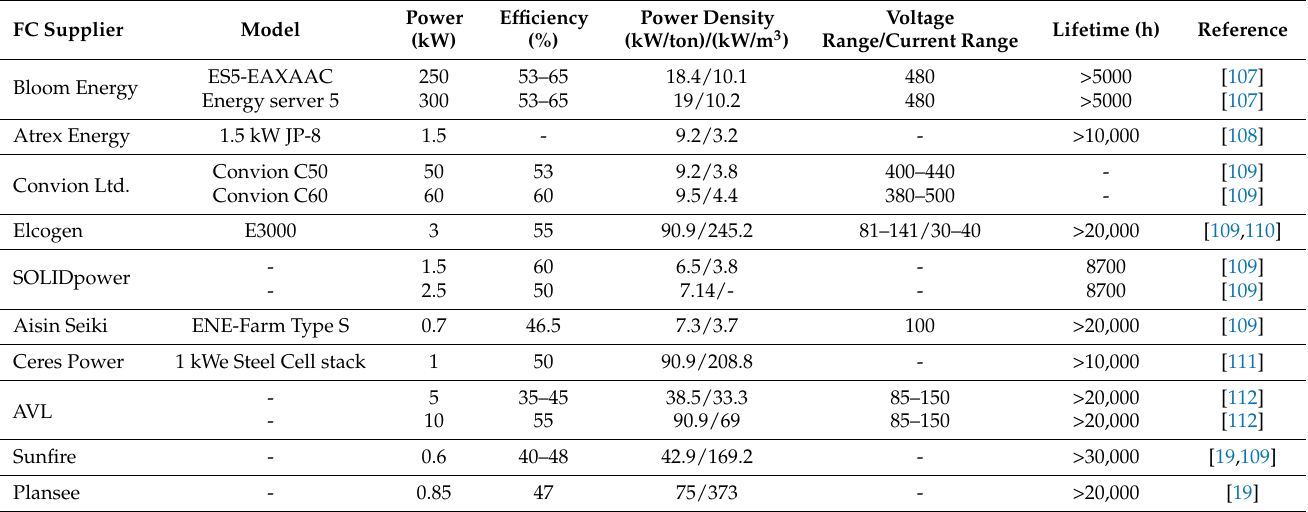
Table 3. Technical specifications of SOFC